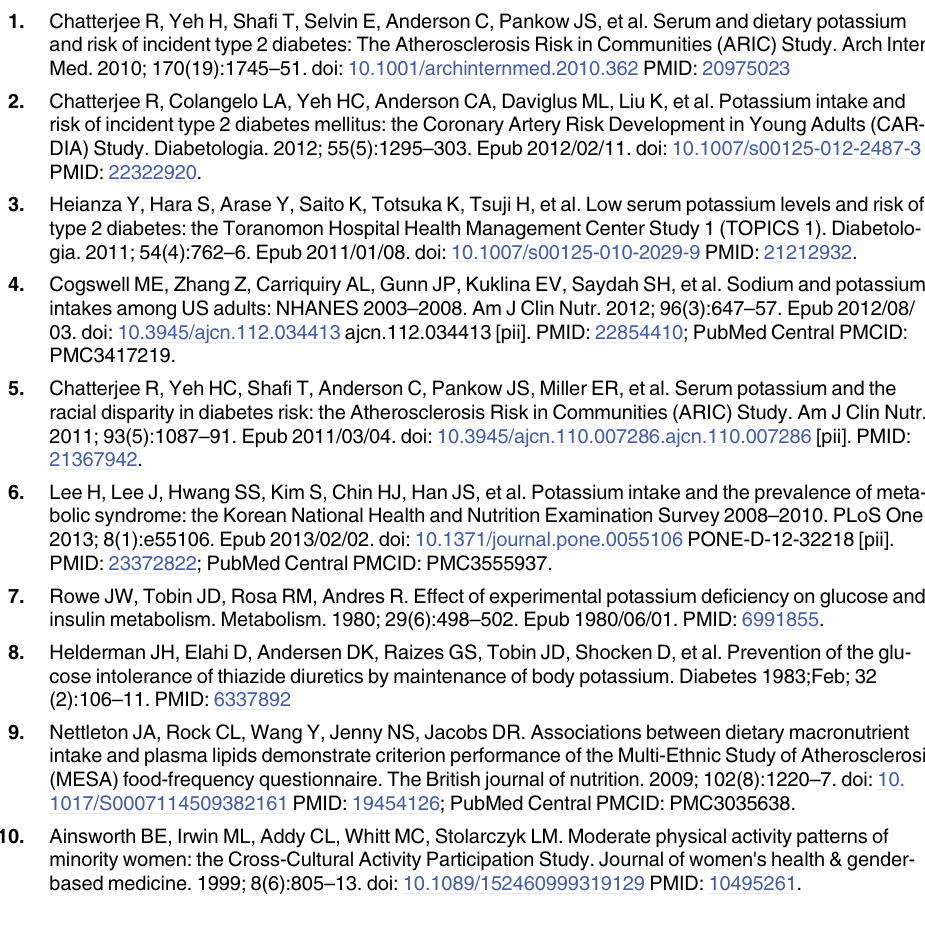
S2 Appendix Table. Associations Between Fractional Excretion (%) (FEK) of Potassium and Fasting Glucose, by Ethnicity. S3 Appendix Table. Associations Between Fractional Excretion (%) of Potassium (FEK) and Incident Diabetes, by Ethnicity. S4 Appendix Table. Baseline Characteristics of non-diabetic MESA participants included and excluded from analysis